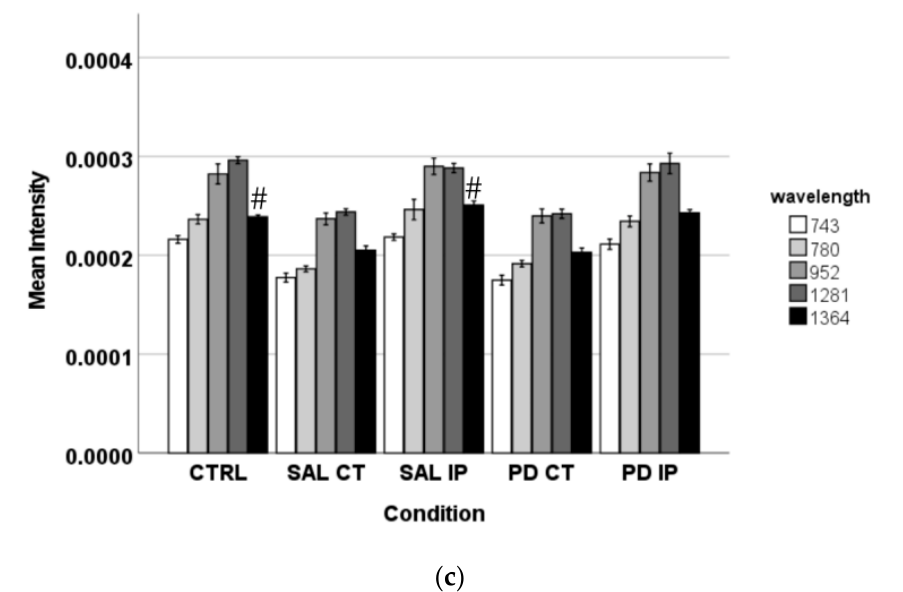
Figure 5. The intensity of the peaks responsible for the separation of the different groups of unlabeled samples found by OPLS-DA was measured in the corresponding Raman spectra. The graphs represent their mean intensity ± SEM from the spectra acquired in the interval from 0 to 3800 cm -1 . ( a ) Values for the unique peaks appearing in the comparison between control (CTRL) and the ipsilateral hemisphere of the 6-OHDA-lesioned mice (PD IP). ( b ) Values for the unique peaks appearing in the comparison between both hemispheres of the 6-OHDA-lesioned mice (PD CT and PD IP). ( c ) Values for the unique peaks appearing in the comparison between control (CTRL) and the ipsilateral hemisphere of the saline mice (SAL IP). One-way ANOVA or Welch’s ANOVA followed by Bonferroni or Games-Howell post hoc test, respectively, was performed, with * p < 0.05 and # p < 0.001. The sampling distribution was first tested for normality using the Shapiro-Wilk test and for homogeneity of variances using the Levene’s test.